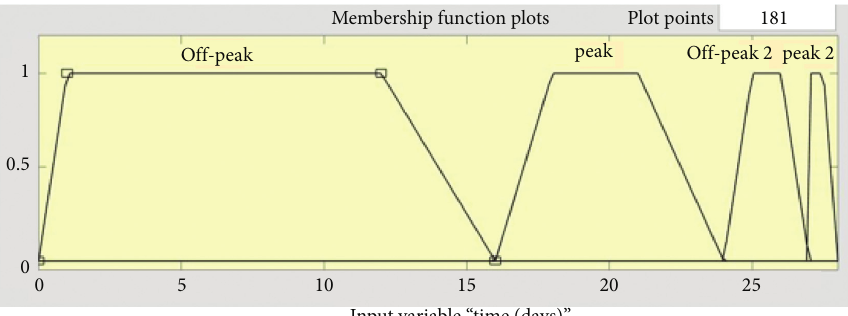
Figure 5: Input membership function for time.